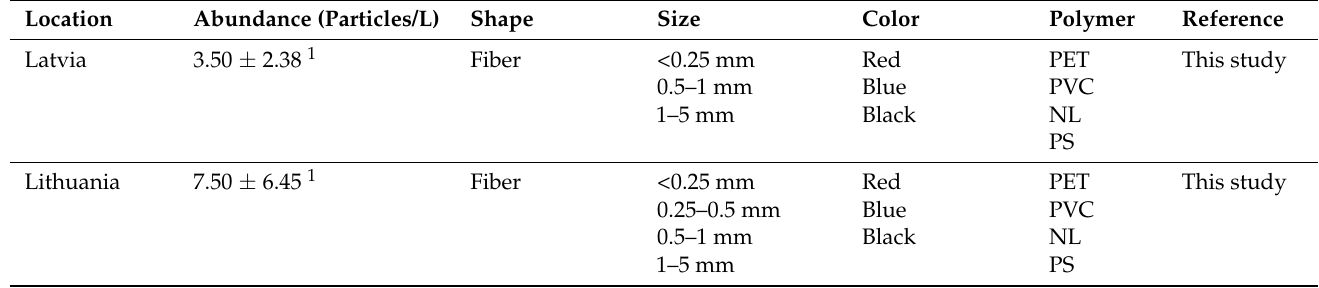
Table 1. The abundance of MPs found in surface water and wastewater from different locations in the world, with the most abundant morphology, color, and chemical composition.